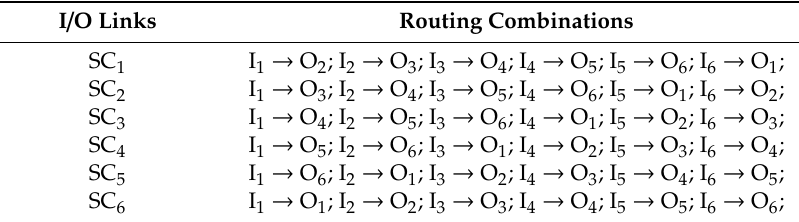
Table 2. Routing combinations for the 6-port optical switch.